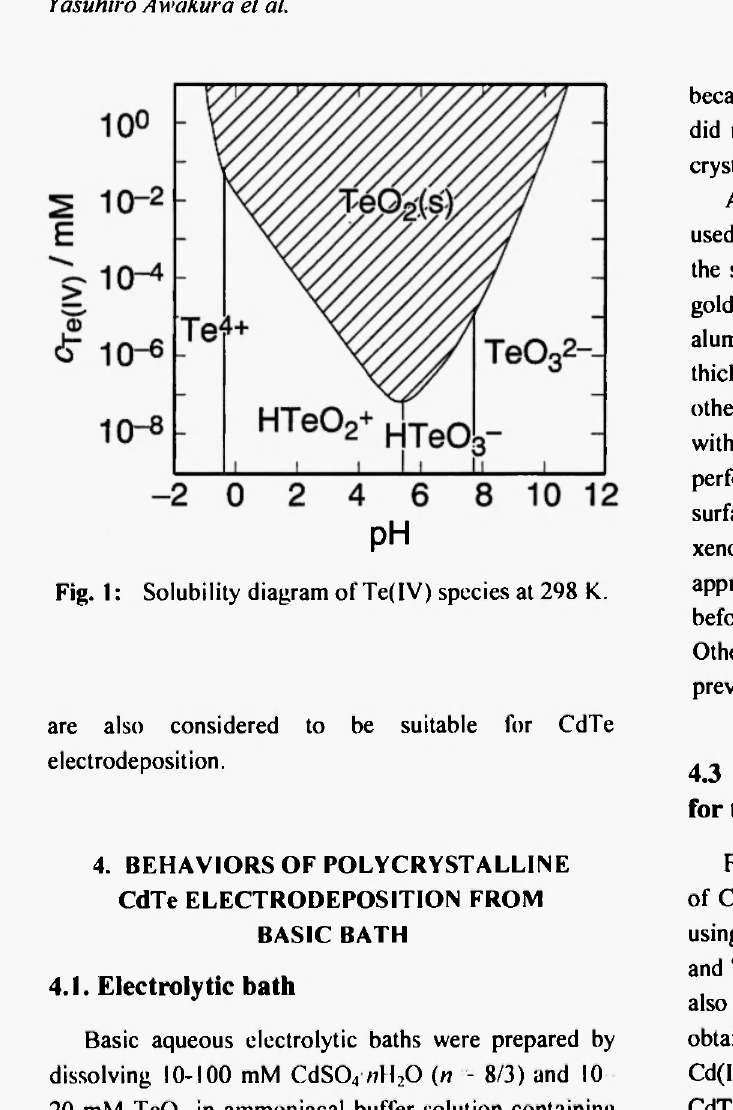
Fig. 1: Solubility diagram of Te(IV) species at 298 K.